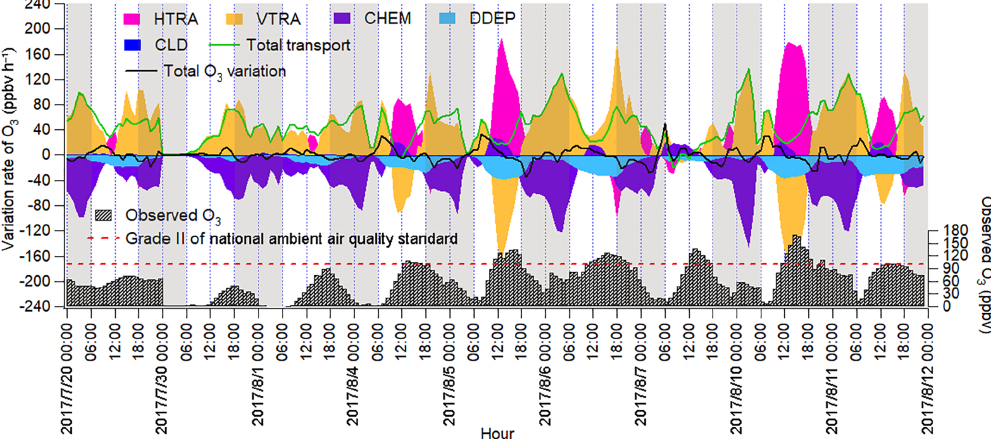
Figure 6. Time series of O 3 variation rate in Jinan induced by individual processes calculated based on the change in O 3 per hour. Total transport is the sum of HTRA and VTRA, and the sum of O 3 variation rates attributable to all the processes is represented by the total O 3 variation rate. The nighttime (18:00–06:00LT) has been highlighted in